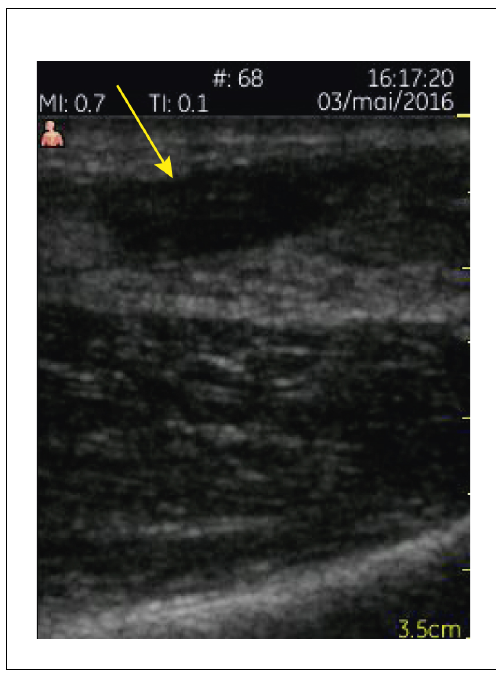
Figure 1. Pocket-sized ultrasound sagittal view of the Achilles rupture.